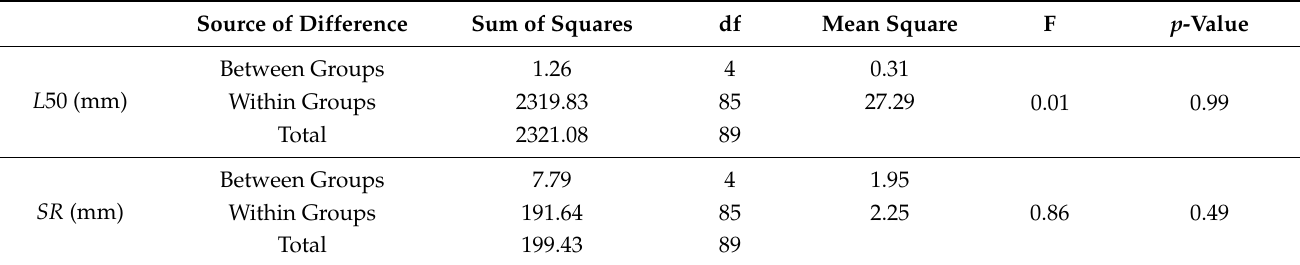
Table 3. One-way ANOVA results of L 50 (lengths of krill at which 50% of the individuals are not captured) and SR (selective range: difference between L 75 and L 25) between replicates.